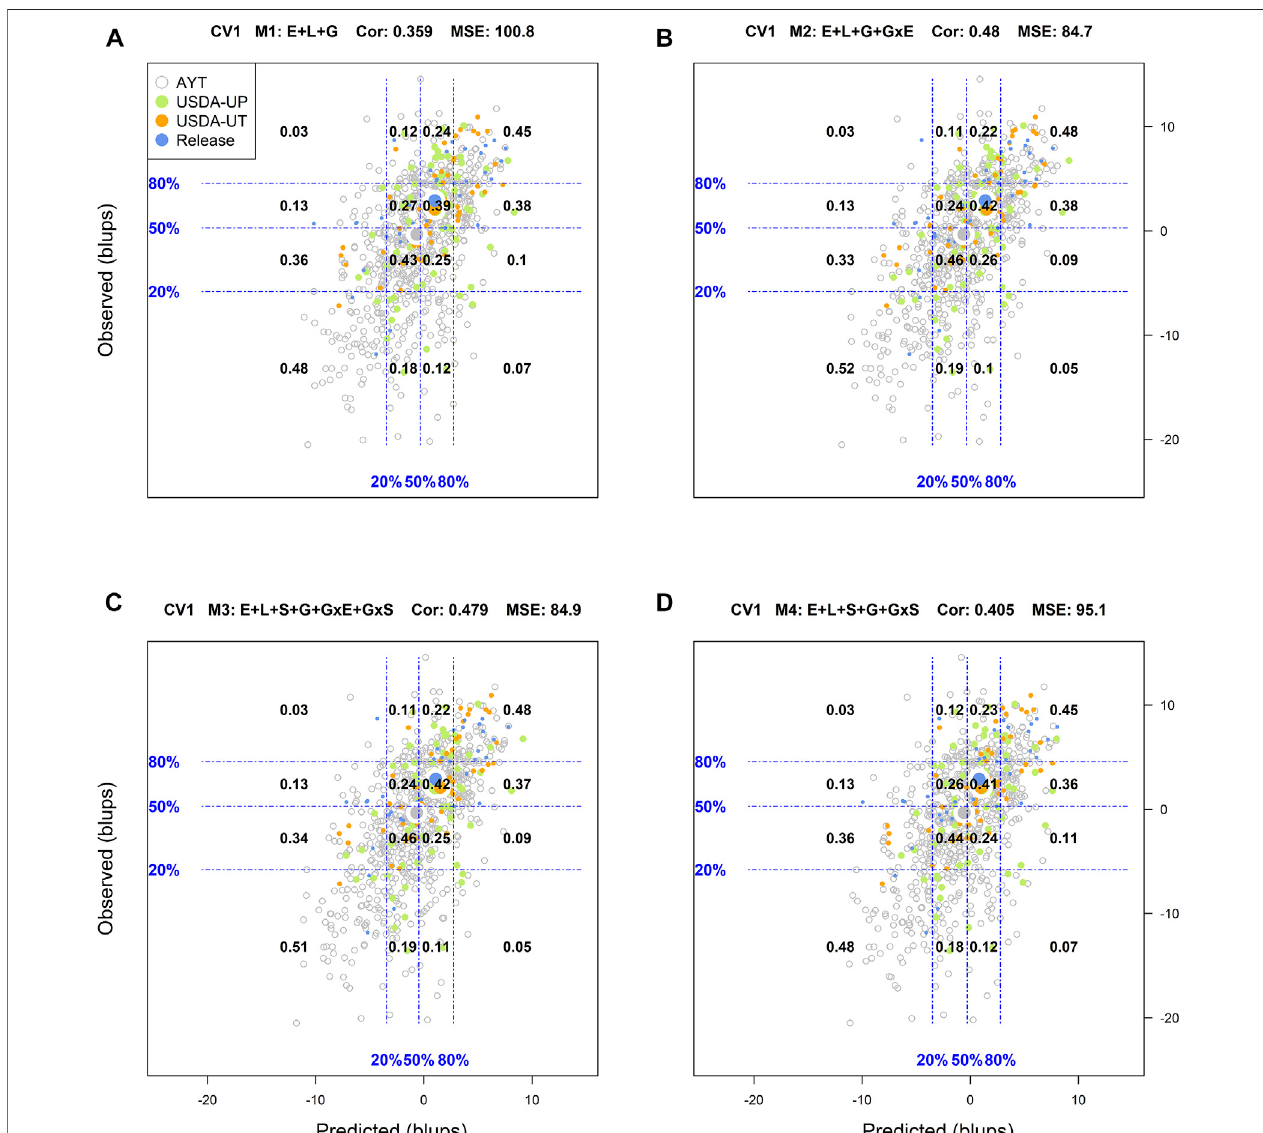
FIGURE 2 | Genotypic means (BLUP-centered on zero within environments) of observed versus predicted cross-validation predictions of four models (M1 – M4) under the cross-validation scheme CV1, which mimics the prediction scenario of newly developed lines (predicting untested genotypes in observed environments). Models and terms are described in detail in the Materials and Methods section ( Eqs 1 – 4 ). Horizontal and vertical dashed lines indicate the 20, 50, and 80% empirical percentiles corresponding to the observed and predicted values; the numbers inside the grid provide the conditional proportions observed on the y -axis for the different percentiles on the x -axis (e.g., out of the top 20% of the predicted values with M3 (panel C), 48% [top right] of these correspond to phenotypes that showed a performance among the 20% in fi